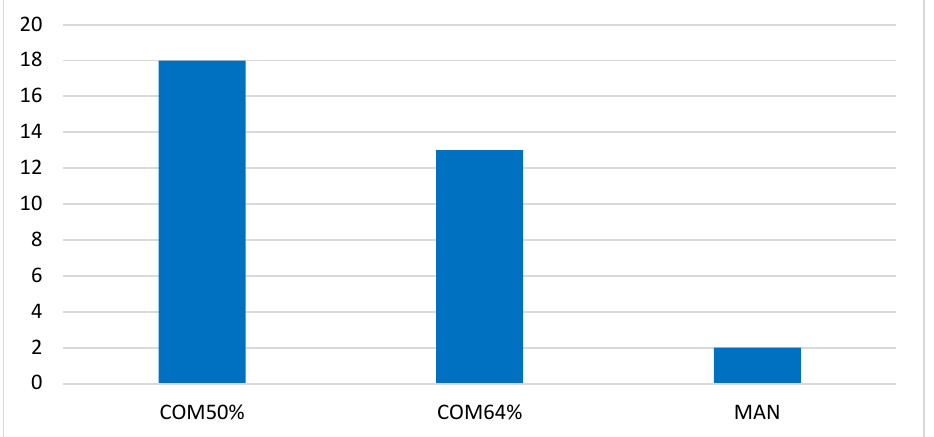
Figure 4. Results of sensory analysis—hedonic method, assessor perception of the samples. MAN—raw chocolate, COM 64%—classic bitter chocolate 64%, COM 50%—light bitter chocolate 50% (COM 50%).